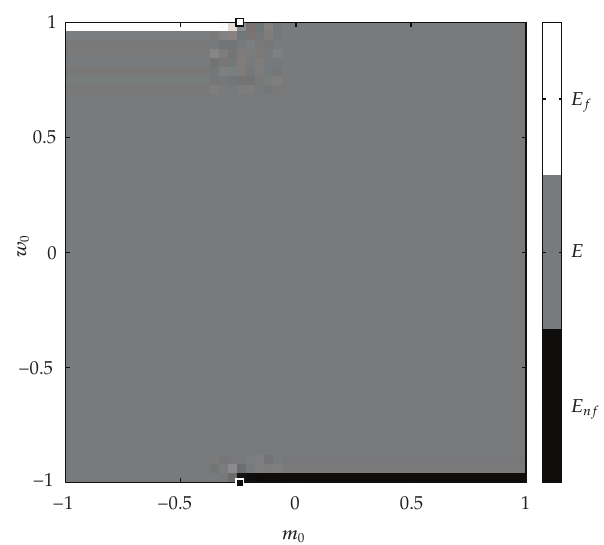
Figure 1: Basin of attraction in the plane (cid:2) m,w (cid:3) for the initial condition x 0 (cid:9) 1 and parameter values a (cid:9) 1, α (cid:9) 4, λ (cid:9) 1, σ 2 (cid:9) 1, r (cid:9) 0 . 02, C (cid:9) 0 . 5 and β (cid:9) 1. The white point corresponds to E f while the black point corresponds to E nf